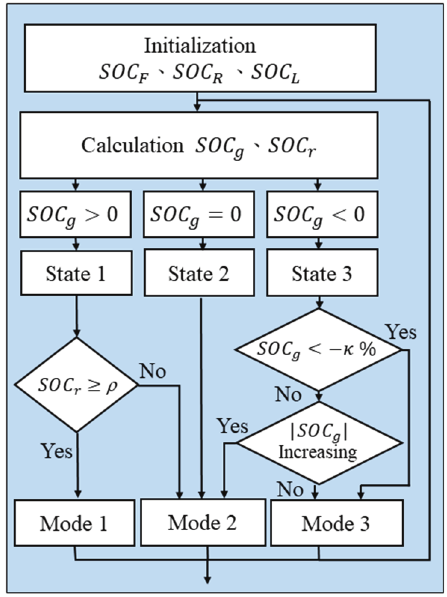
Figure 4. Flowchart of the torque and battery distribution strategy.